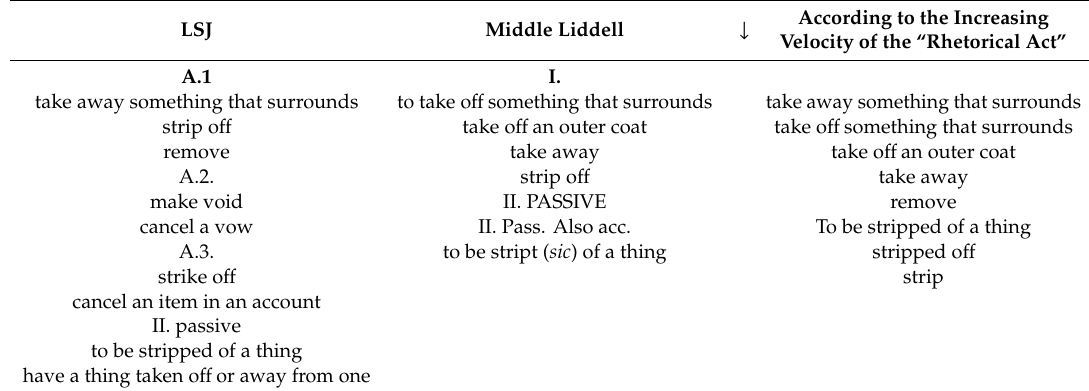
Table 2. Etymological pockets of time in translations of the Greek word περι ´ ελ o ι ,